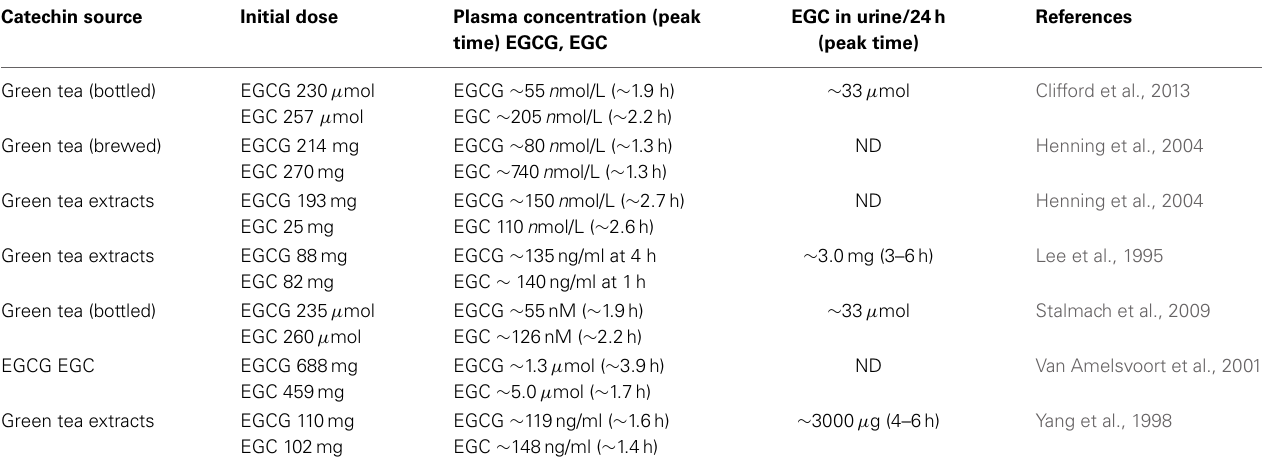
Table 1 | Bioavailability of green tea